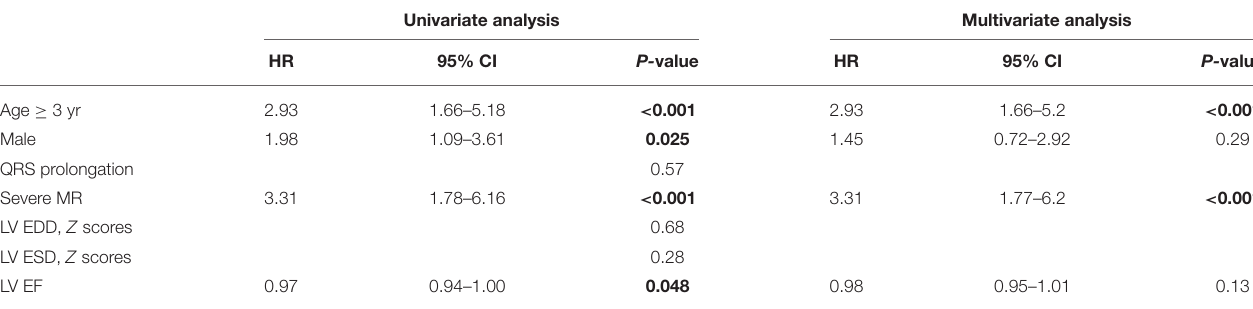
TABLE 3 | Hazard ratios from univariate and multivariate Cox regression model of risk factors for death or transplantation. Univariate analysis Multivariate analysis